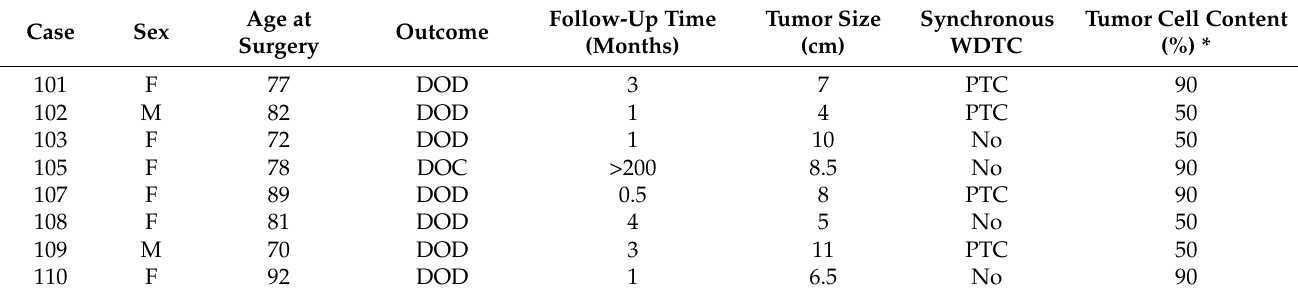
Table 1. Clinical characteristics of the anaplastic thyroid carcinoma cases included in the